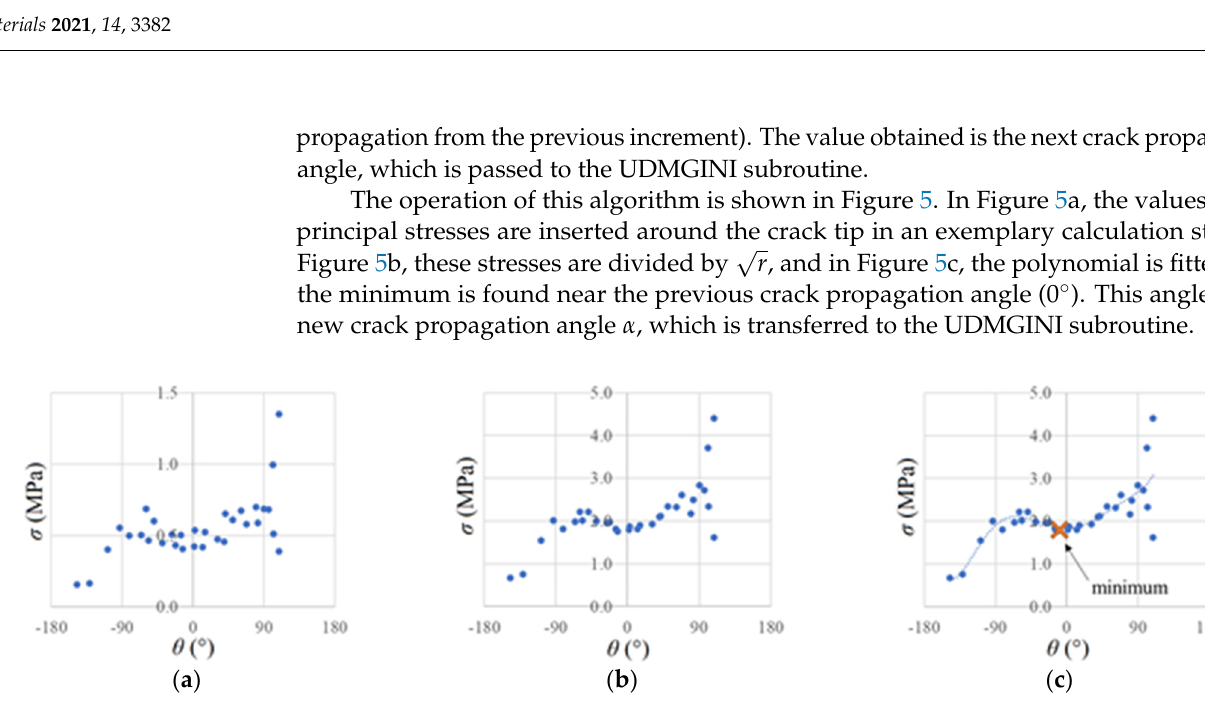
Figure 5. Calculating the new crack angle around the crack tip: ( a ) principal stresses; ( b ) principal stresses reduced to a radius = 1; ( c ) the 6th-degree polynomial is fitted and the minimum is found.